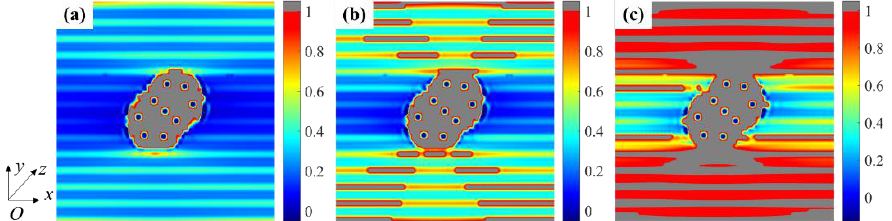
Figure 13. Damage evolution in the repeated needling region under tensile load ( a ) damage initia- tion and needling hole failure ( b ) failure of matrix between unidirectional fibers begins ( c ) fibers failure.